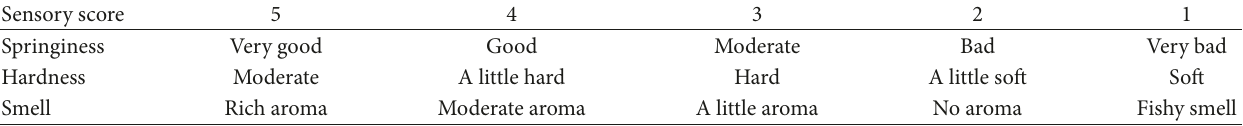
Table 2: Sensory index criterion of abalone